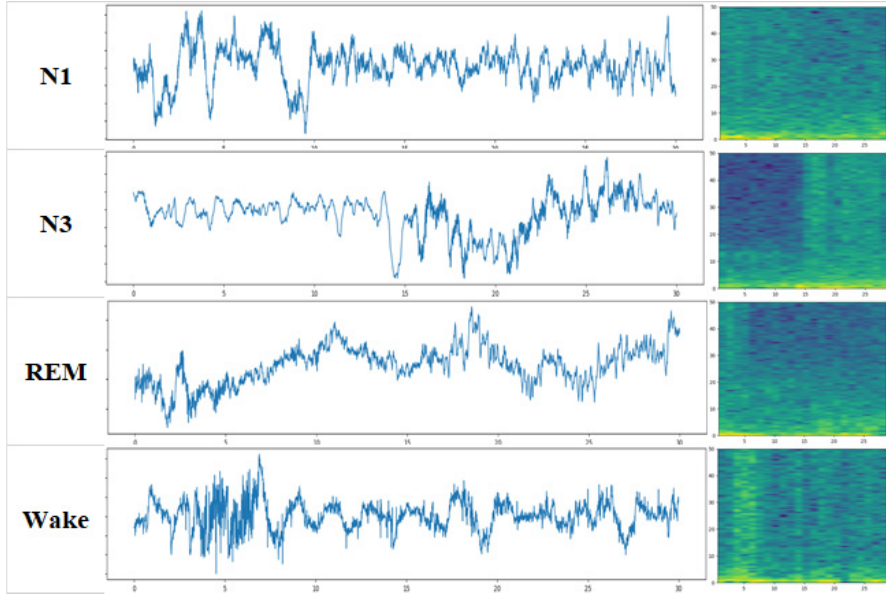
Figure 3. EEG and corresponding spectrograms of N1, N3, REM and Wake, respectively.